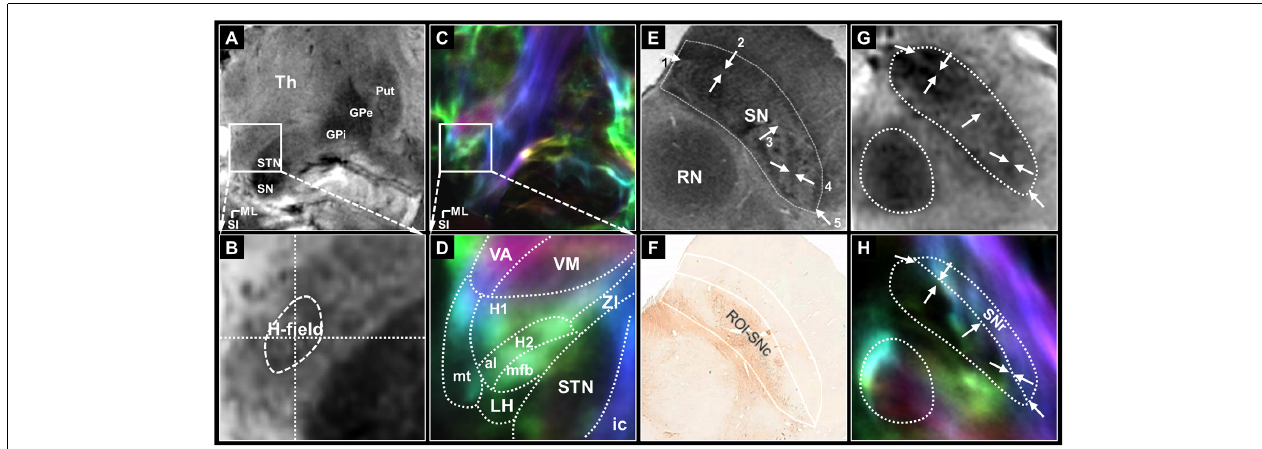
FIGURE 1 | The seed regions for tractography of the pallidothalamic and nigrothalamic pathways. (A,B) The selected (top) and magnified (bottom) views of the seed regions, H-field, obtained with 7T T2* MR imaging. (A) An image obtained with ultra-high-field MR imaging clearly shows the putamen, GPe, GPi, STN, and SN. (B) In the middle of the image, H-field is observed as a darker region containing a hypointense signal in the T2* MR image than the surrounding WM regions. (C,D) The corresponding views were obtained with super-resolution DEC-TDI maps showing the representation of directionality and density. Enlarged view of the Fields of Forel with anatomy depicted by white dotted lines drawn on a coronal section 33 (14.6 mm posterior to the AC level) modified from the stereotactic atlas of Mai (Mai et al., 2008) (D) . (E,F) In ex vivo imaging, the whole SN ROI corresponding to most of SN hypointensity on the 7T T2* MR image (E) , the SNc ROI based on the TH stain within the whole SN including the A9 cell group (F) adapted from Lee et al. (2016). (G,H) The corresponding section of the SN from the T2* (G) and TDI (H) images in this study. White arrows, such as those shown in (E) , indicate the referenced anatomical landmarks for parcellation of the SNr. The SNr ROI is based on the TDI mapping within the whole SN (H) . For anatomical annotations and orientation abbreviations, see those described in Figure 2 captions. H1, fasciculus thalamicus; H2, fasciculus lenticularis; LH, lateral hypothalamic area; ZI, zona